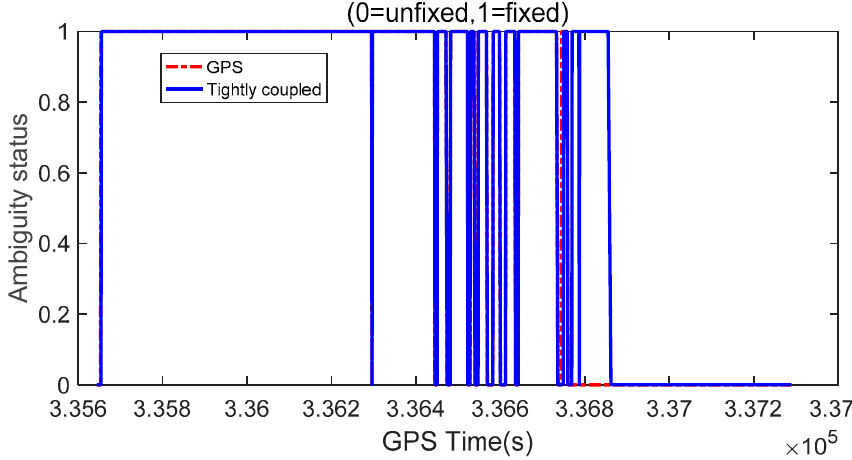
Figure 13. The ambiguity status of GPS and the tightly coupled system.